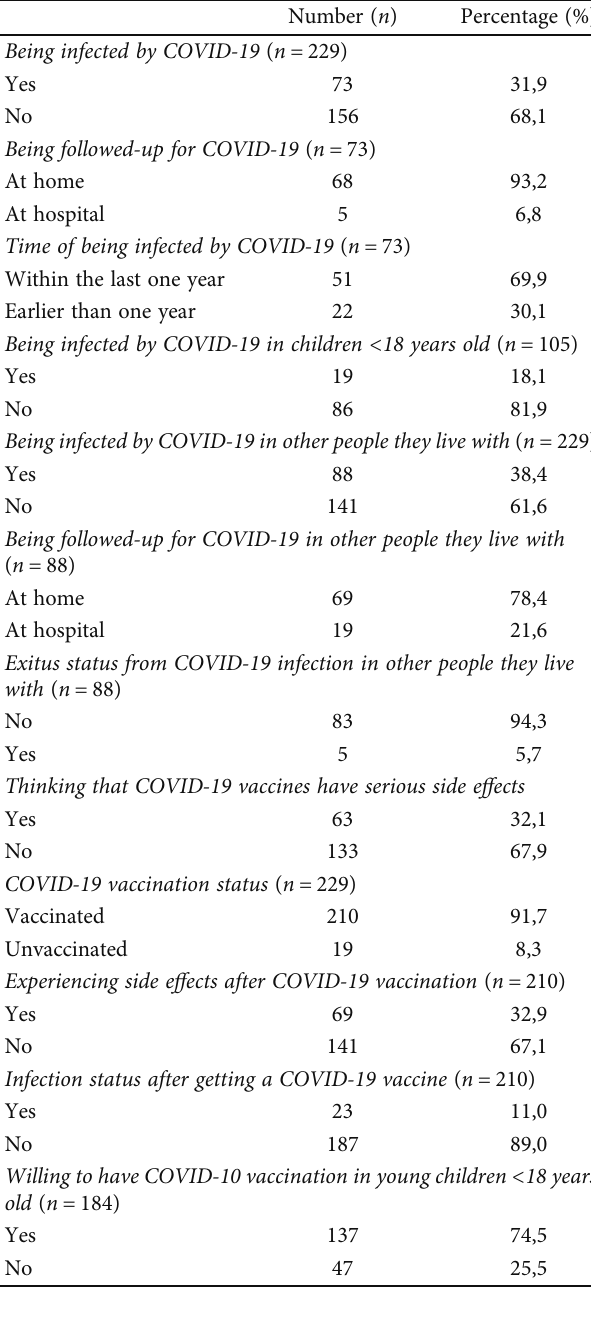
Table 2: Characteristics of participants regarding COVID-19 infection and vaccines, Kastamonu,